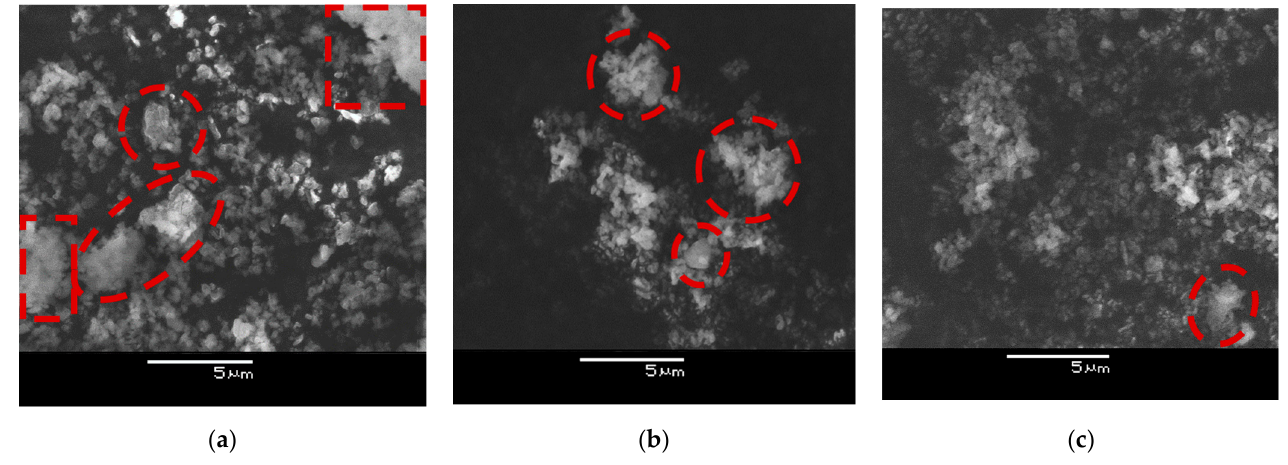
Figure 4. SEM images of BM powders: ( a ) 1 h 400 rpm; ( b ) 1 h 600 rpm; ( c ) 1 h 800 rpm. Visible agglomerates are circled in dashed lines.